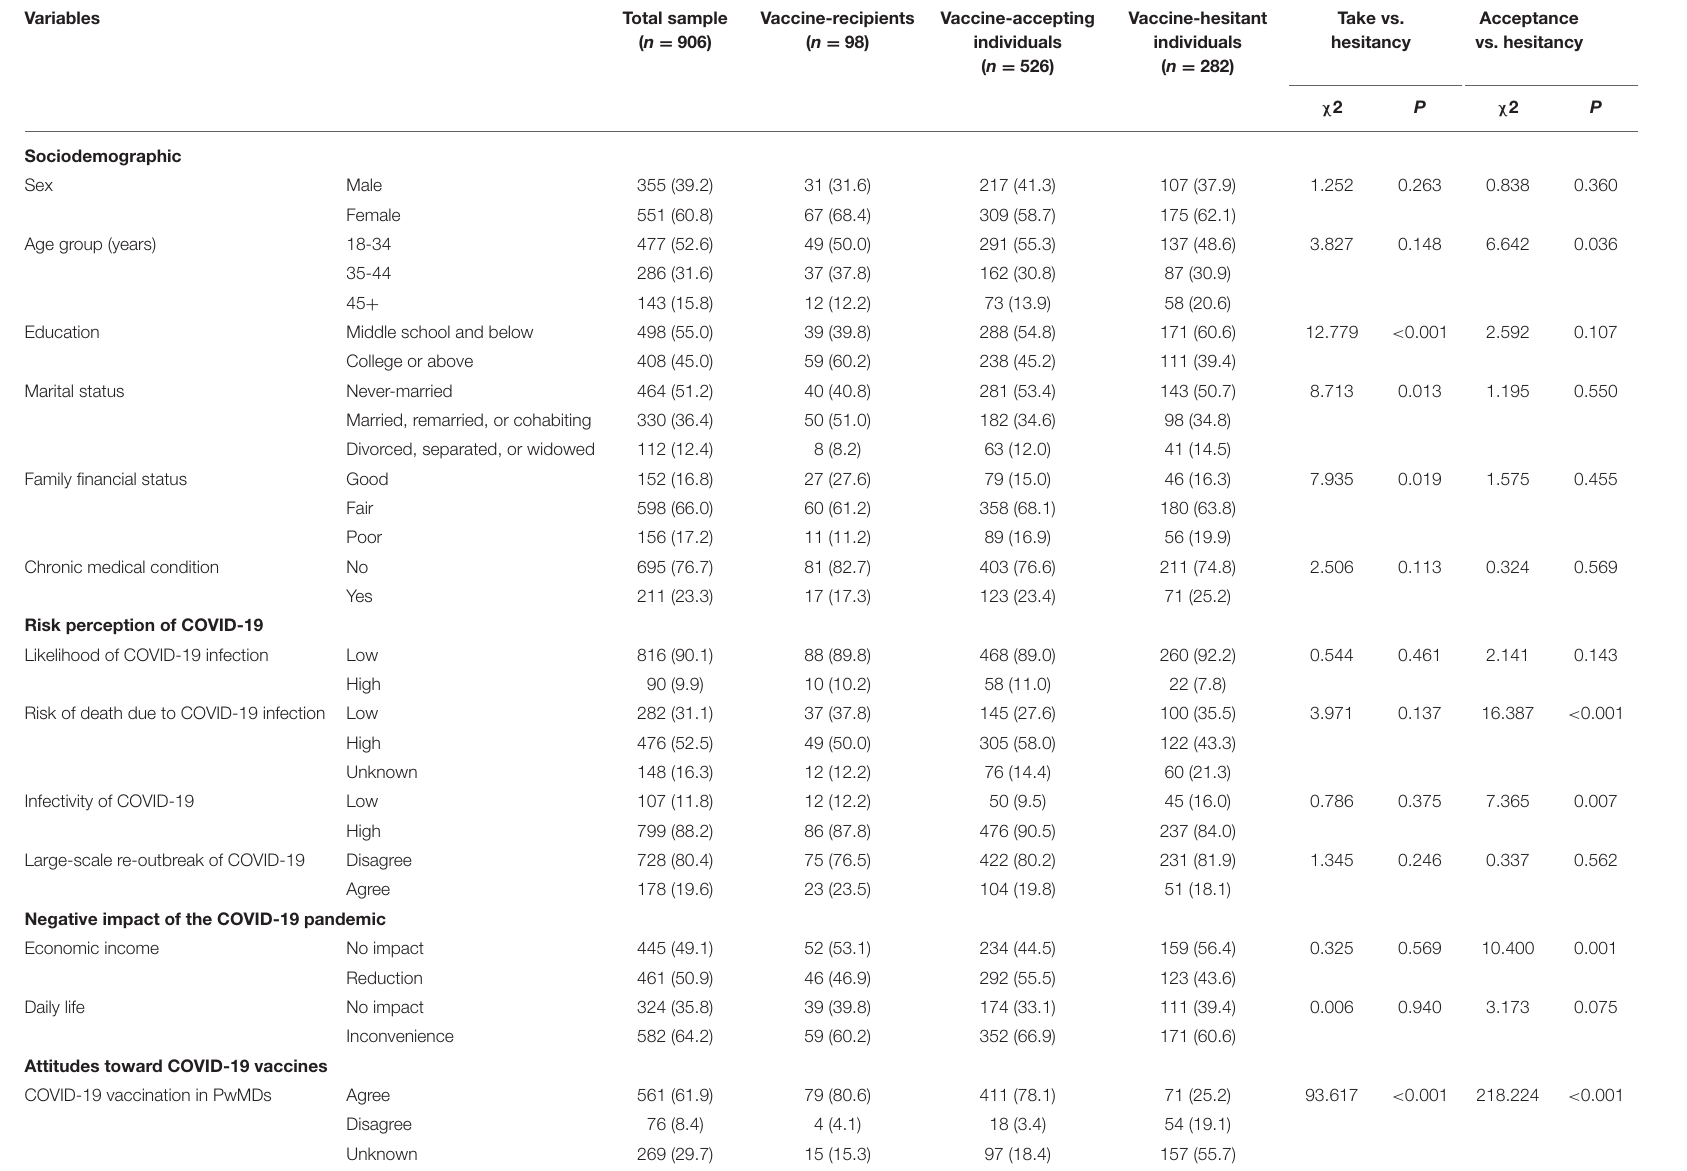
TABLE 2 | Characteristics of COVID-19 vaccine-recipients and vaccine-accepting individuals in comparison to vaccine-hesitant individuals among Chinese persons with mental disorders (PwMDs), n (%). Variables Total sample